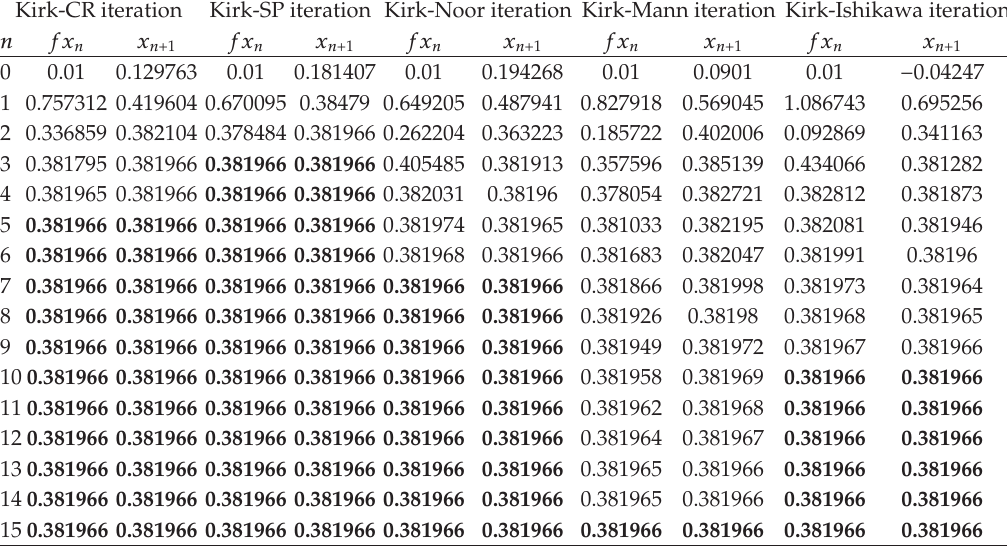
Table 3: Functions with multiple zeros.